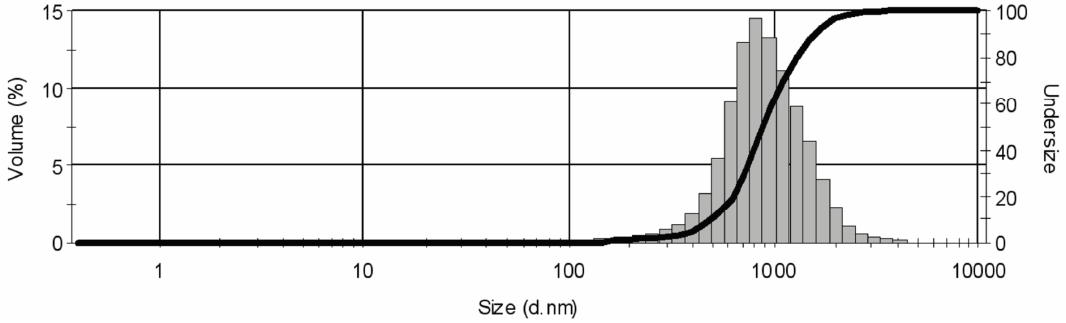
Figure 7. UV-Vis absorption spectrum of CuO suspension (Table 1, sample 9).